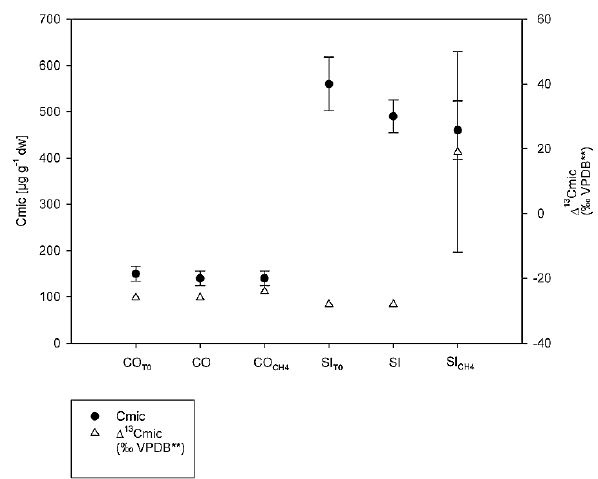
Fig. 2. Microbial biomass (Cmic) and δ 13 C content of microbial biomass ( δ 13 Cmic) before (CO T 0 , SI T 0 ) and after the incubation experiment without (CO, SI) and with methane (CO CH Results are presented as means ± standard deviation ( n = 8 for SI CH and CO CH ; n = 5 for SI T 0 , CO T 0 and SI, CO). 4 4 ∗∗ Vienna Pee Dee Belemnite.